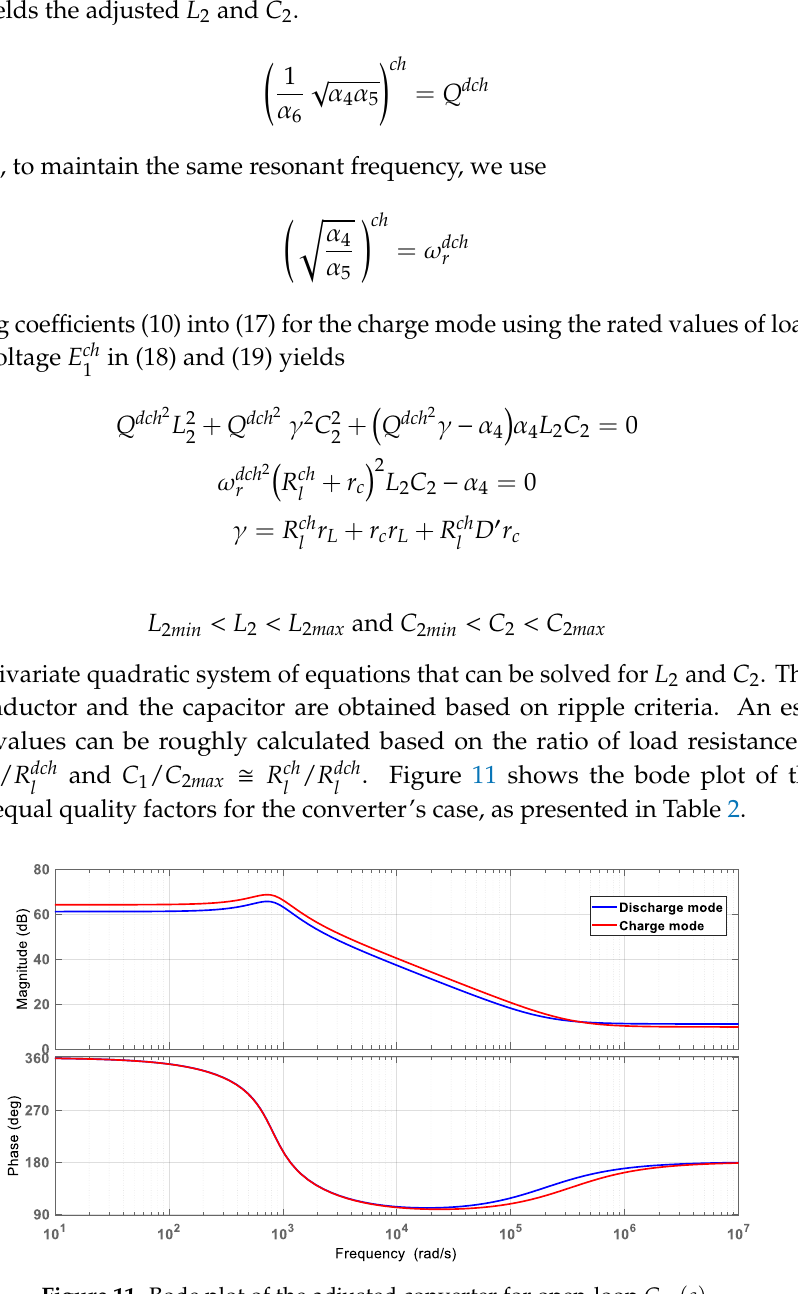
Figure 11. Bode plot of the adjusted converter for open-loop 𝐺 11 (𝑠).